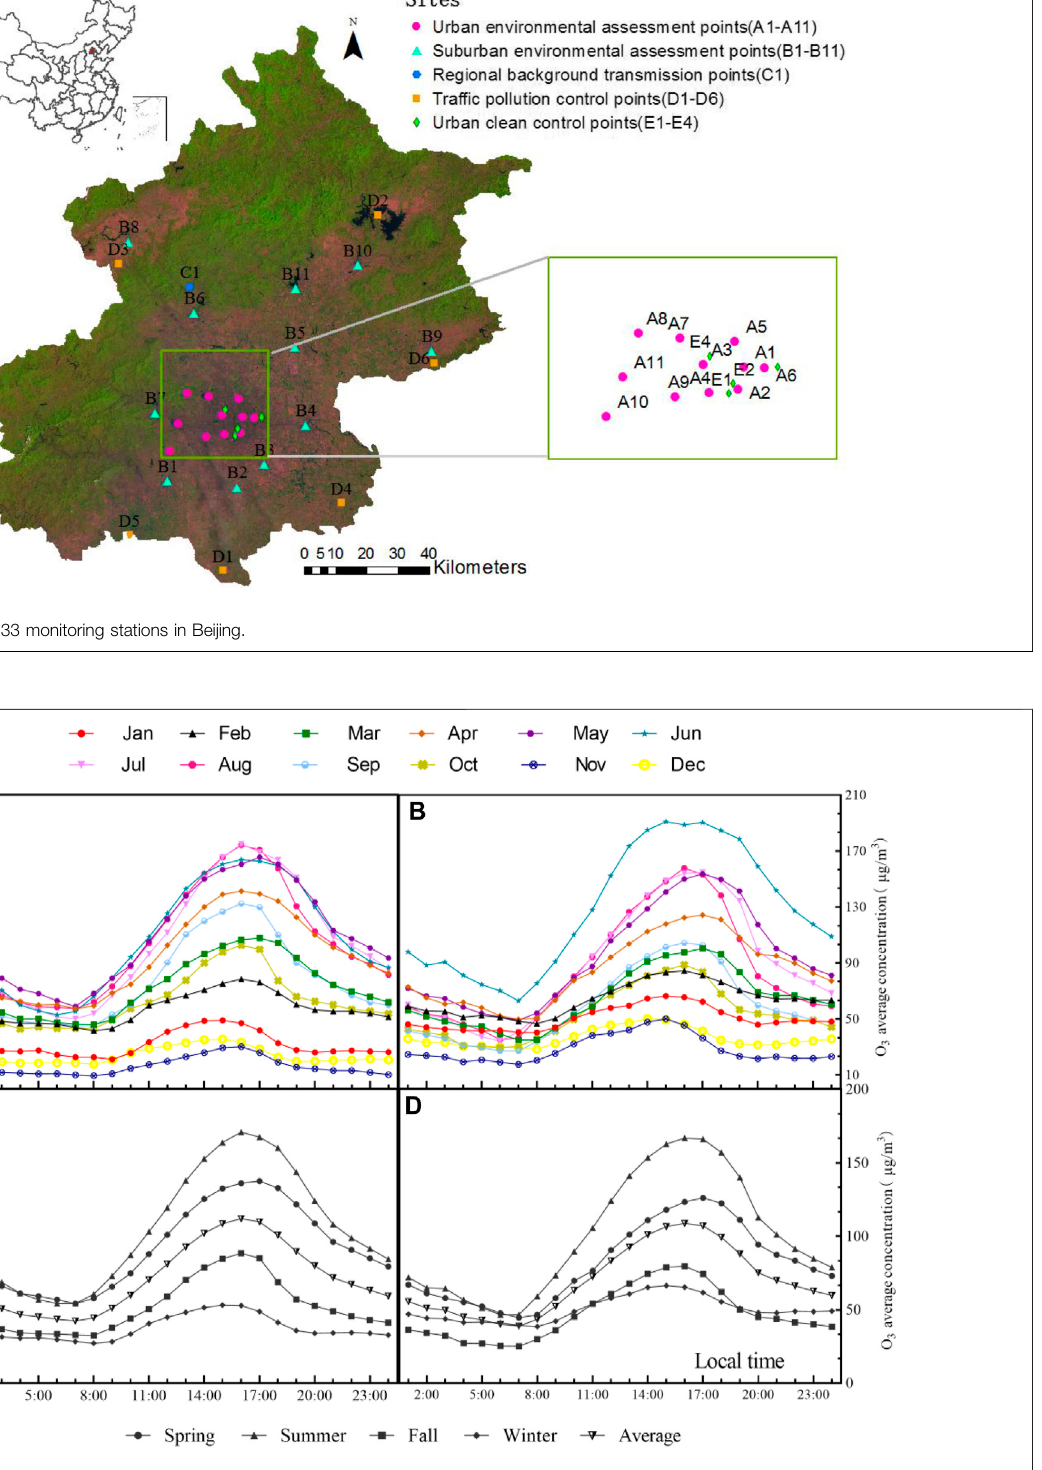
Frontiers in Environmental Science |